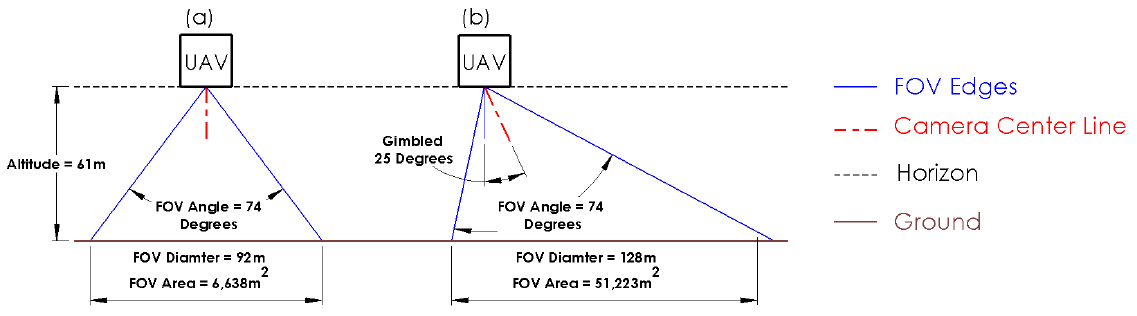
Figure 4. Nominal (a) and 25 ◦ Rotated (b) Camera